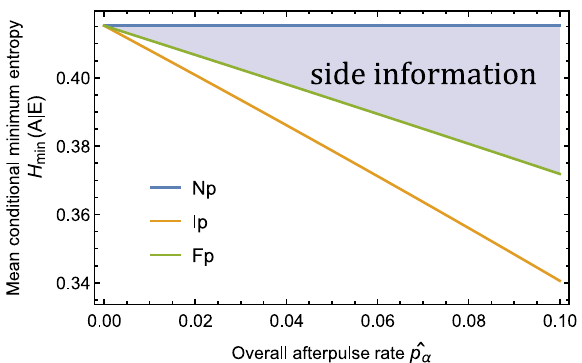
Fig. 3 The relation between H min ( A ∣ E ) and ^ p α with no afterpulse (Np), previous in fi nite afterpulse (Ip) and previous fi nite after- pulse (Fp), which consists of 1000 pulses. The factors ω α = 0.001 and A α are related to ^ p α . The pulses with coherent states that contain ν = 10 photons insert SPDs with η α = 0.1 and e d = 6 × 10 − 7 . The shadow gap is the side information leaked to Eve due to the afterpulse.